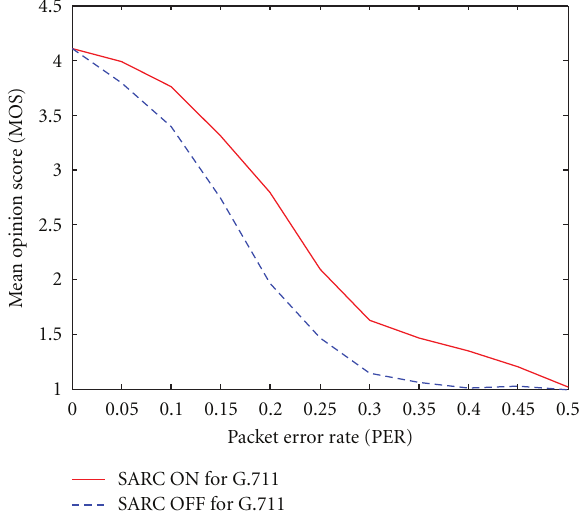
Figure 7: G.711 Voice MOS against Packet Error Rate.